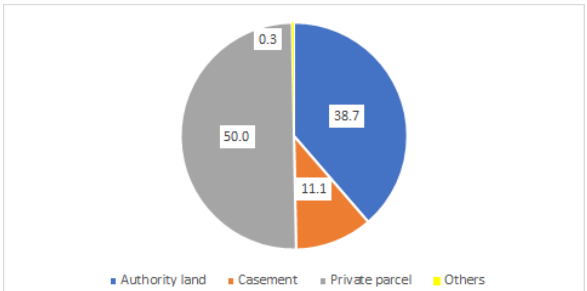
Figure 12. Percentage distribution of tree coverage area in different cadastral